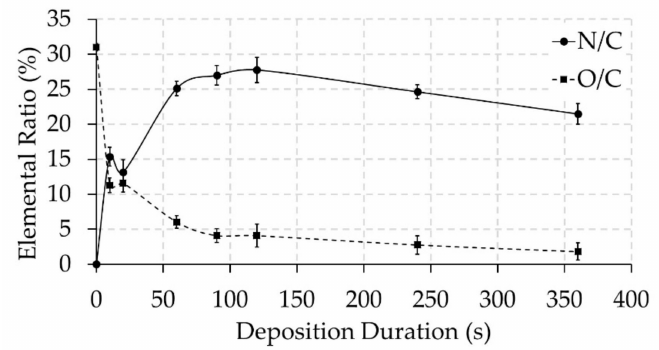
Figure 3. Evolution of the N / C and O / C ratio as a function of plasma deposition